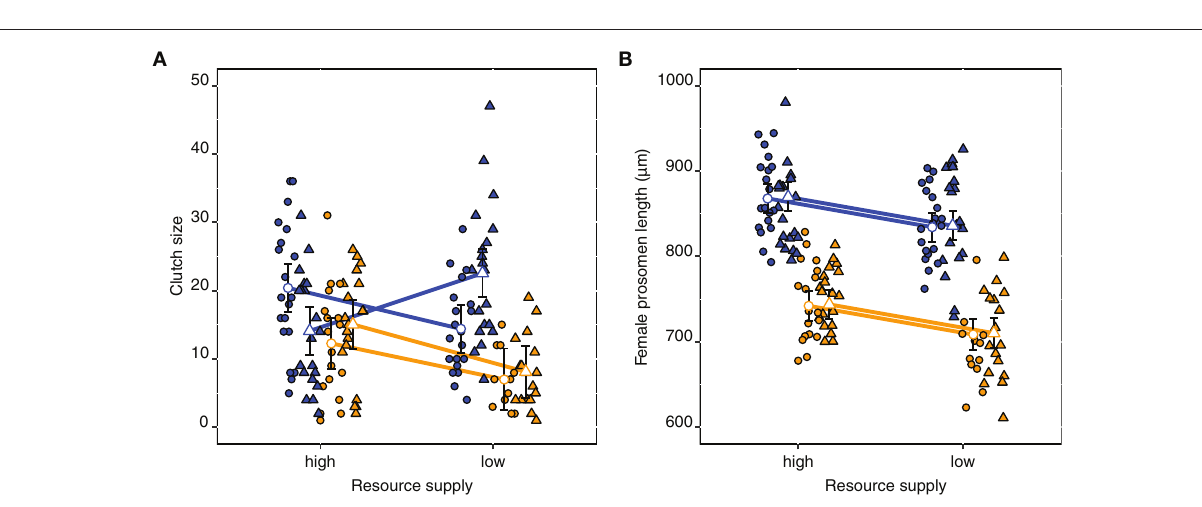
FIGURE 7 | Clutch sizes (A) and females prosome lengths (B) for the STHLM (orange) and the GOR (blue) E. affinis populations at the end of the experiment. Triangles and circles are respective pelagic and benthic treatments, the resource supply treatment is shown on the x-axis. Observations are included as points. Estimates and 95% CI are fitted by restricted maximum